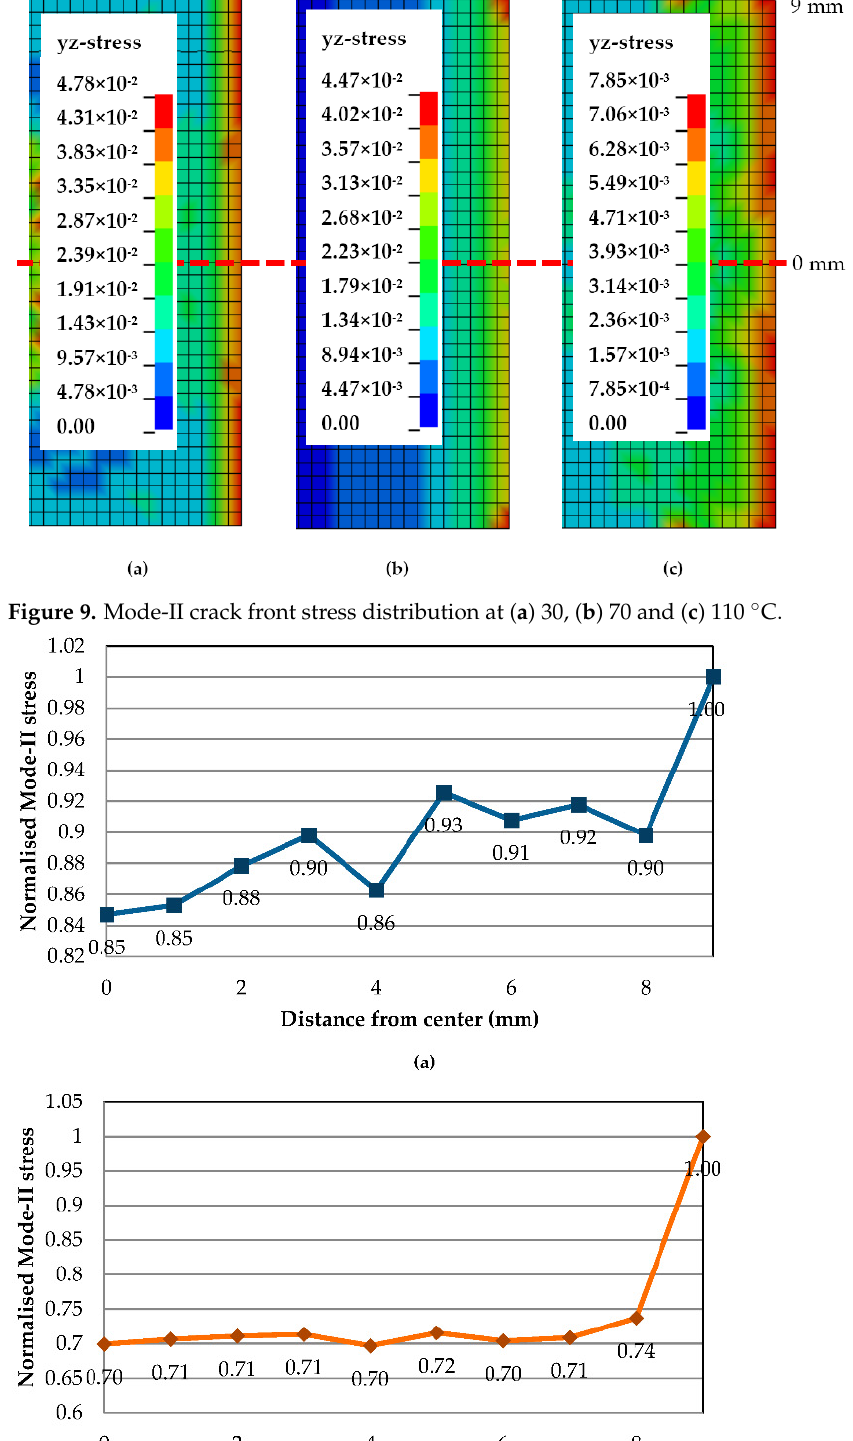
Figure 10. Normalised Mode-II stress distribution along crack tip at ( a ) 30, ( b ) 70 and ( c ) 110 °C. 5. Conclusions This paper utilises finite element cohesive zone modelling to evaluate temperature effects on Mode-I and Mode-II delamination between aluminium and a GFRP laminated hybrid. Separate temperature-adjusted material models are applied for the aluminium, GFRP and cohesive zone to simulate the effects of temperature to full accuracy. After val- idation, localised stresses across the crack tips are plotted, where the variation of stress distributions leading to crack initiation are compared between each temperature. • The validity of the FE model at each temperature is verified with a slope maximum difference within 5.73% for Mode-I at 110 °C and 7.26% for Mode-II at 70 °C. • Crack front stress is concentrated in the middle for Mode-I, while stress is focused on the sides of Mode-II delamination. Results for 30 °C are characterised by a more fluc- tuating gradual stress variation for both modes.